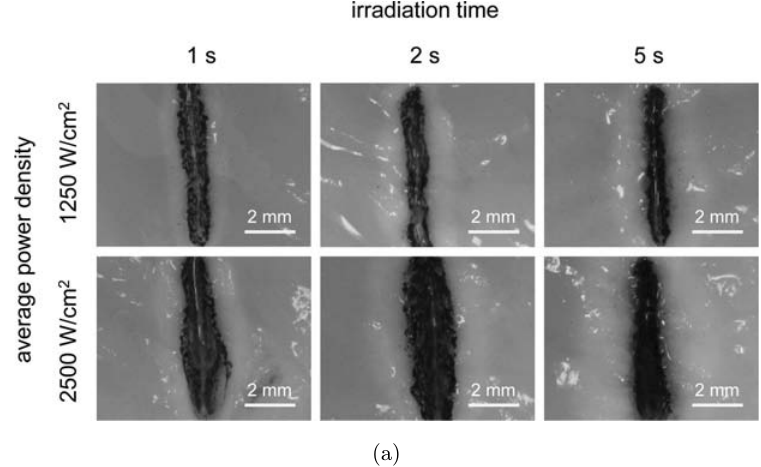
Fig. 6. E®ects of CO 2 laser irradiation on chicken breast tissue. (a) Surface view and (b) cross-sectional